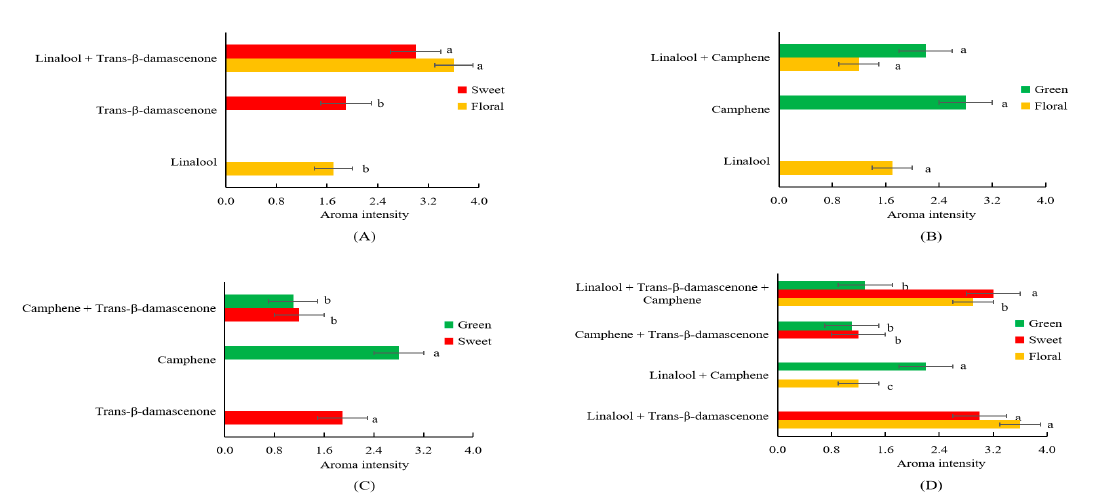
Figure 3. Interactions of linalool and trans - β -damascenone ( A ), linalool and camphene ( B ), trans - β -damascenone and camphene ( C ) and linalool, trans - β -damascenone and camphene ( D ). In each figure, di ff erent letters (a, b, c) behind columns in the same color represent significant di ff erence in the aroma intensity ( p < 0.05).